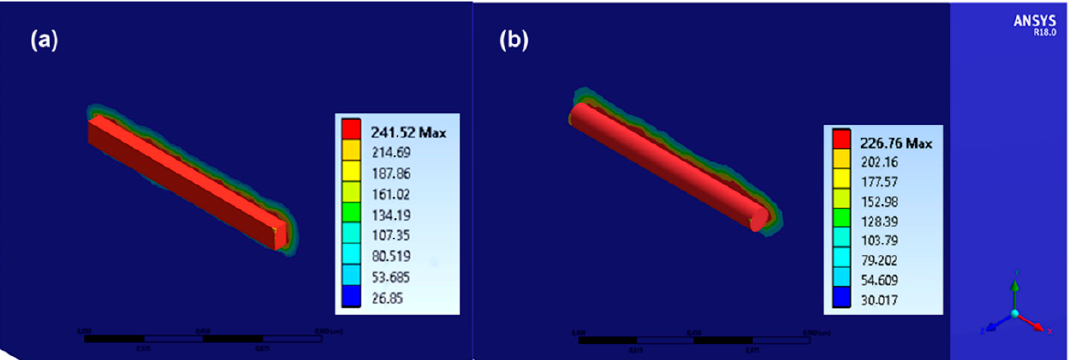
Figure 8. Lateral temperature distribution immediately after the effect of a 10 ns pulse. ( a ) Cuboid parallelepiped geometry, max temperature 241.5 °C. ( b ) Cylindrical geometry, max temperature 226.4 °C. The x - y plane heat affected zone in both cases is sub-micrometric, and dictated by the geometry of the